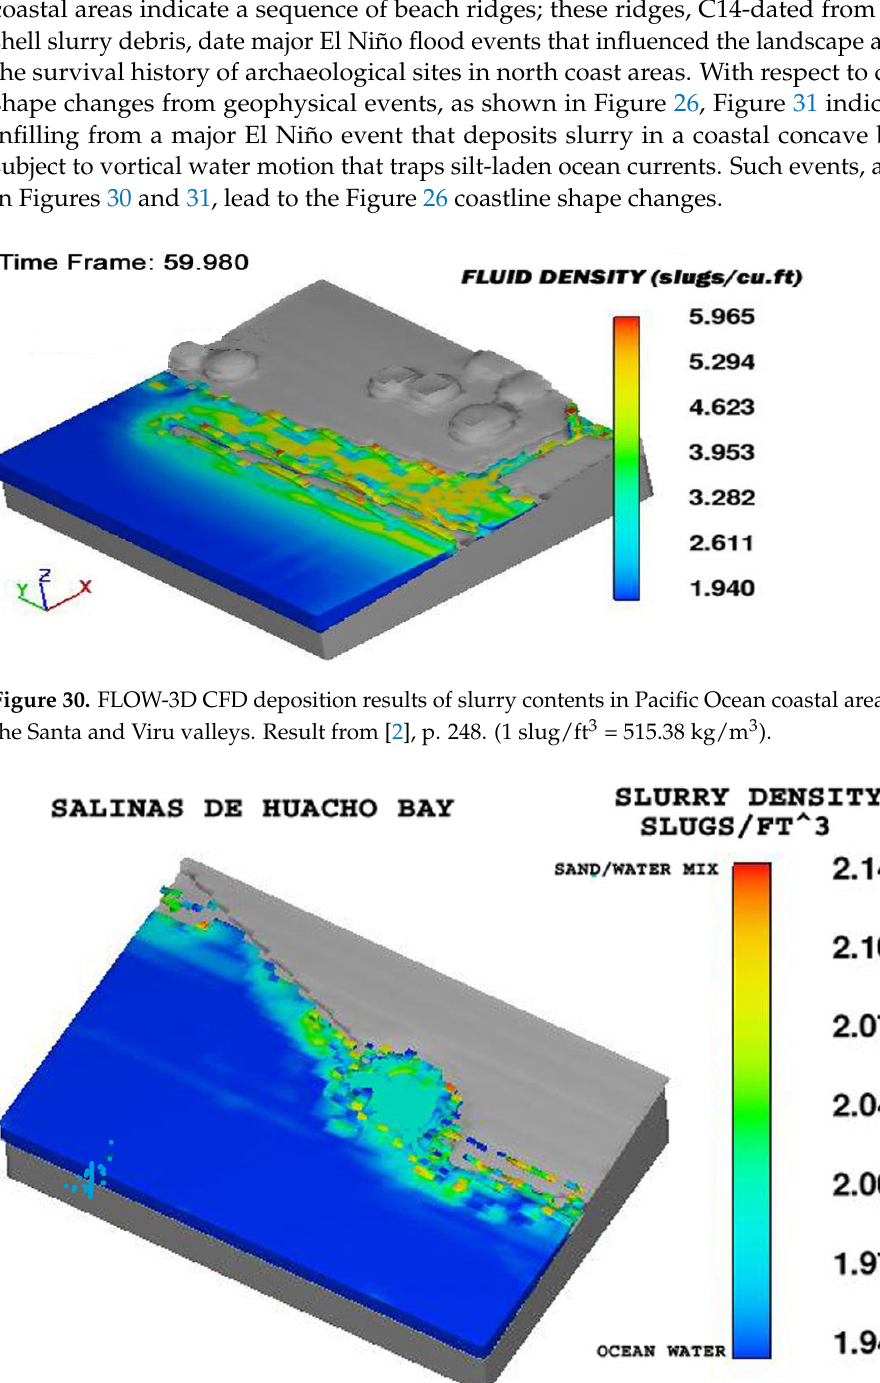
Figure 31. FLOW-3D CFD prediction of a coastline change that proceeds from a major El Niño event that traps silt laden ocean water to deposit in bay areas. Result from [2], p. 249. (1 slug/ft 3 = 515.38 kg/m 3 ).